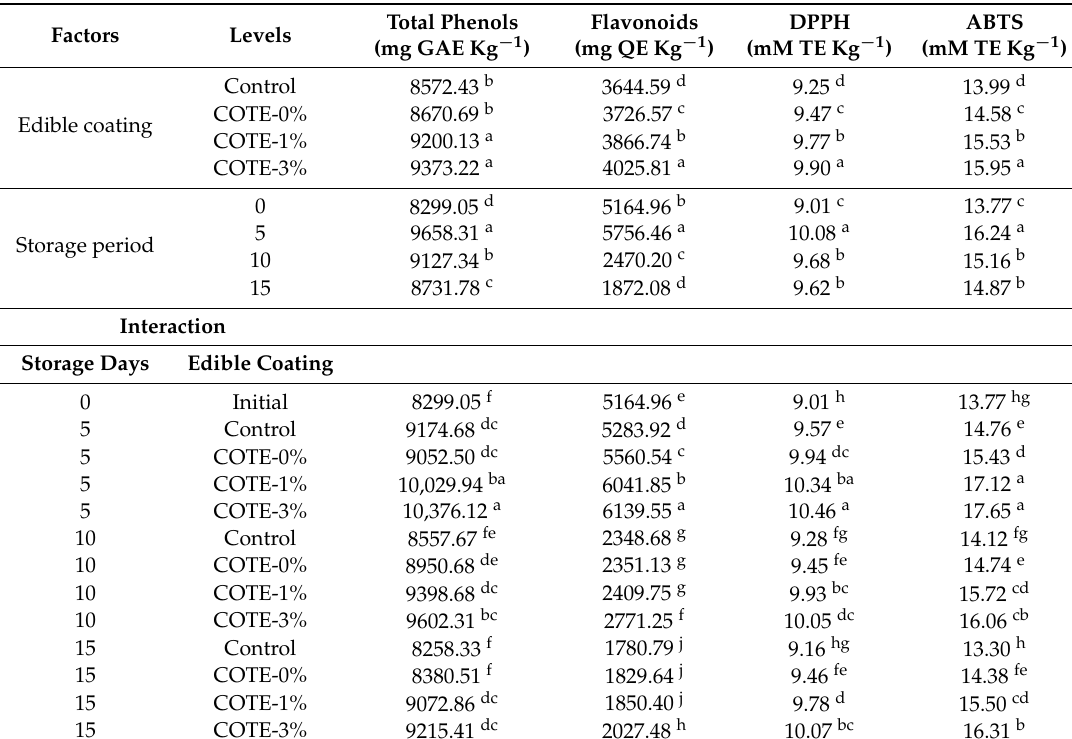
Table 4. Effect of edible coating incorporated with tomato oily extract and storage period on bioactive compounds and antioxidant activity of Myrtillocactus geometrizans fruits during